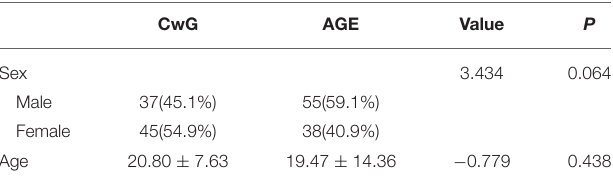
TABLE 1 | Comparison of general information for CwG and AGE